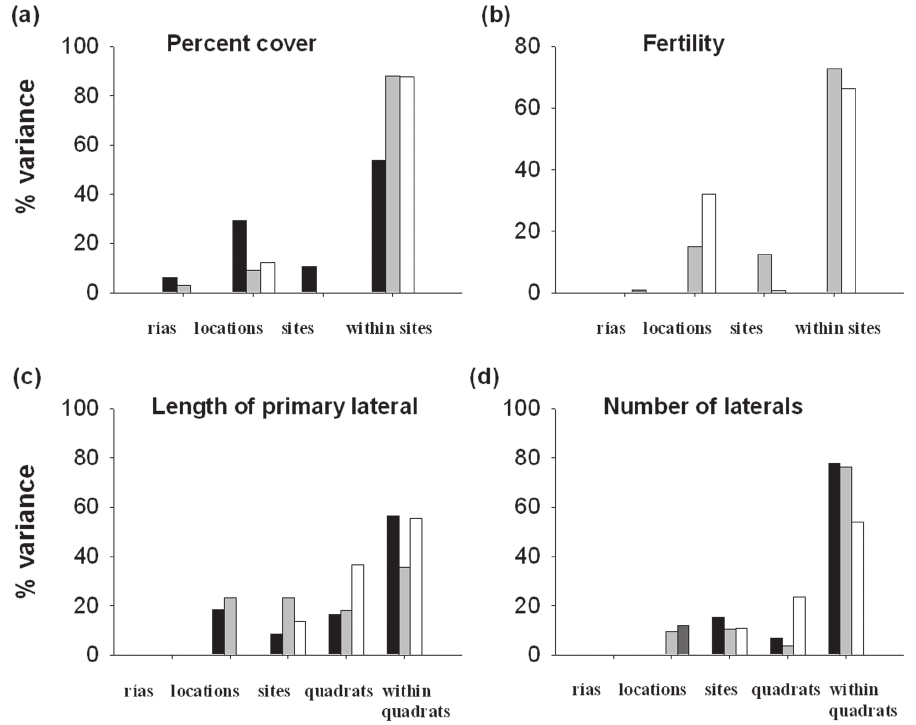
Fig . 5. – Components of variation at 4 (phenological variables) and 5 (morphological variables) spatial scales show variation in different variables. (a) Percent cover, (b) fertility, (c) length of primary lateral and (d) number of laterals. Overall variation is partitioned among scales and expressed as a percentage of the total. negative variance components were converted to 0. black, grey and white bars represent March, april and July,